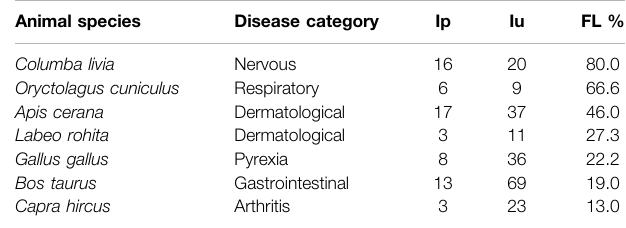
FIGURE 5 | Plant parts used in the preparation of ethnomedicine. TABLE 4 | Informant consensus factor for animal and animal-plant recipes.